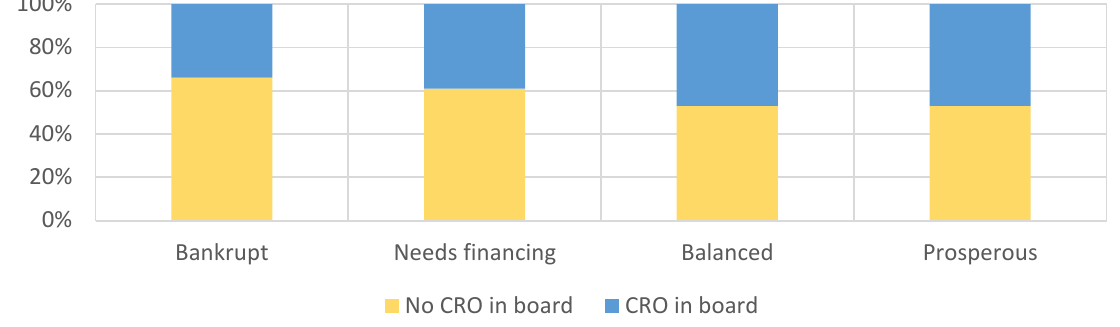
Figure 1. CRO presence for each of the four final